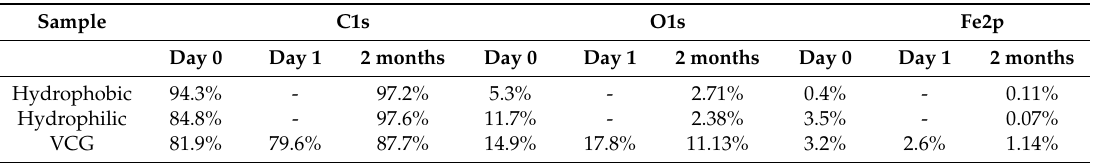
Table 4. Chemical composition of samples obtained through the XPS survey (full spectra provided